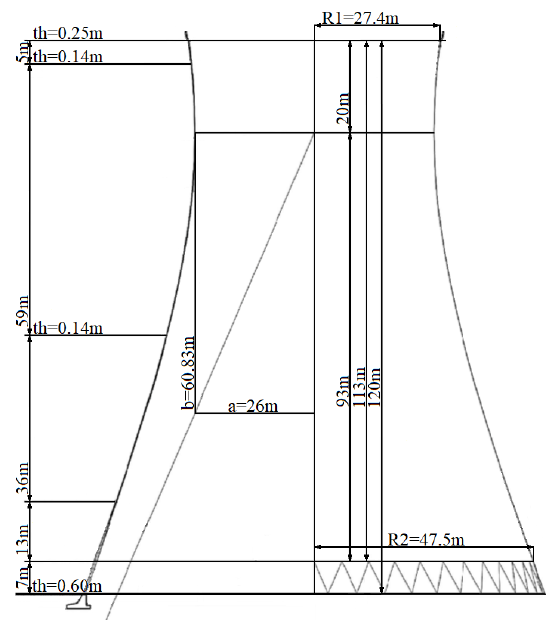
Figure 8: Diagram of the Rybnik chimney (cf. [11,